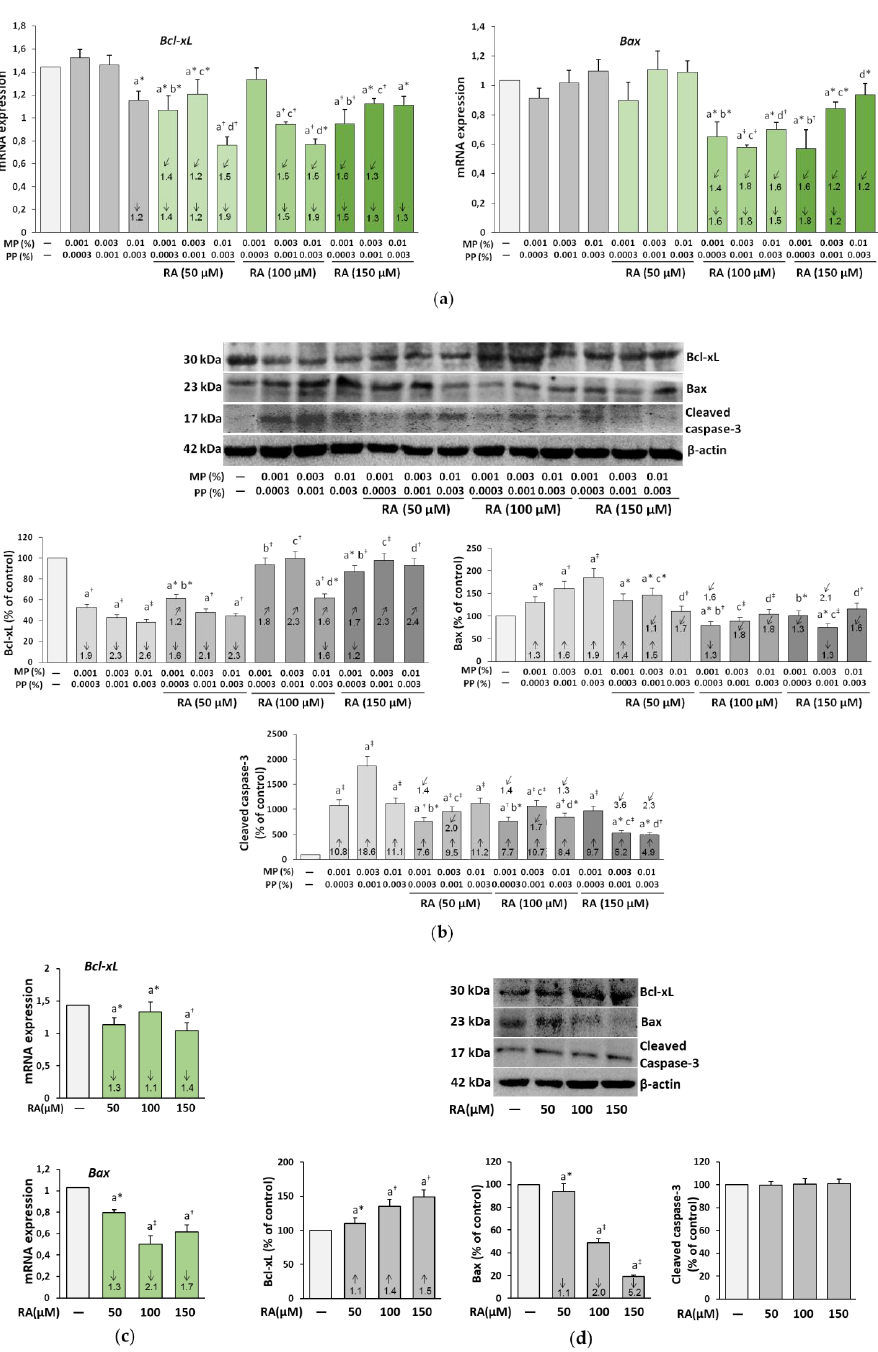
Figure 12. The influence of rosmarinic acid (RA) on the expression of B-cell lymphoma-extra large antiapoptotic protein (Bcl-xL), BCL2-associated X protein (Bax), and caspase-3 at mRNA ( a , c ) and protein ( b , d ) levels in the fibroblasts treated with methylparaben (MP) and n-propylparaben (PP) ( a , b ), and untreated cells ( c , d ). Expression of genes was assayed by real-time PCR, values represent the mean ± SD of three experiments done in duplicate ( a , c ). Representative gels of Western blotting ( b , d ), the intensity of the bands was quantified by densitometry and normalized to β-actin, values represent the mean (% of control) ± SD of three experiments. Statistically significant differences are marked as: a vs. control, b vs. 0.001% MP and 0.0003% PP, c vs. 0.003% MP and 0.001% PP, d vs. 0.01% MP and 0.003% PP; * p < 0.05; † p < 0.01; ‡ p < 0.001. The values in the bars show a factor of change in comparison to the control ( , increase; , decrease) or to the respective samples treated with parabens alone (MP and PP) ( ↗ , increase; ↙ , decrease).